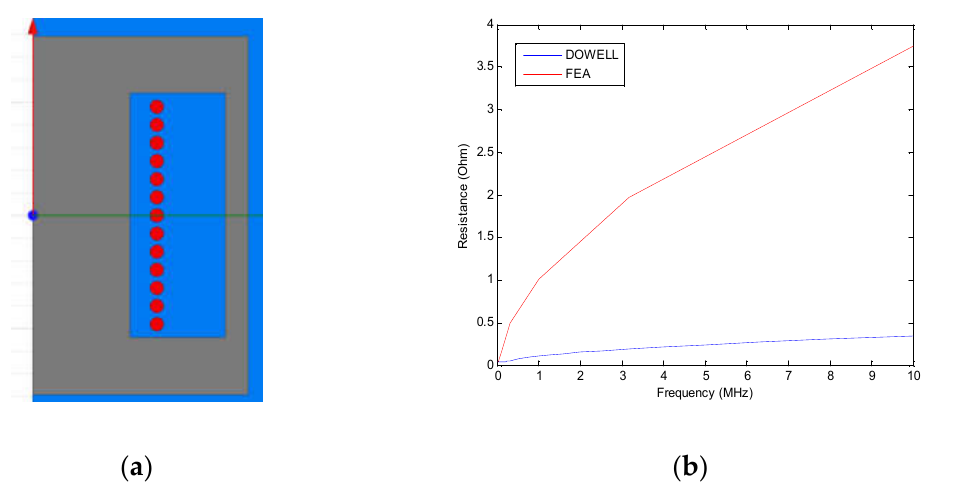
Figure 1. ( a ) Axisymmetric representation of a magnetic component with 13 turns (0.6 mm in diameter and a separation between turns of 0.1 mm); ( b ) the equivalent resistance vs. frequency in the component with an air gap (in the central leg) of 0.4 mm, calculated by means of Dowell’s equation and FEA.